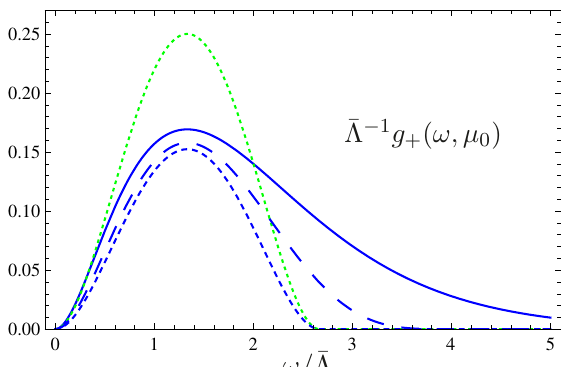
Figure 4 . Four models for the two-particle twist-4 DA g + ( ω ) described in the text: Model I (5.14) (solid), Model IIA (5.24) (short dashes), Model IIB (5.28) (long dashes), and the “naive” local duality model (5.22) (green dots). For this plot we have taken R = λ 2